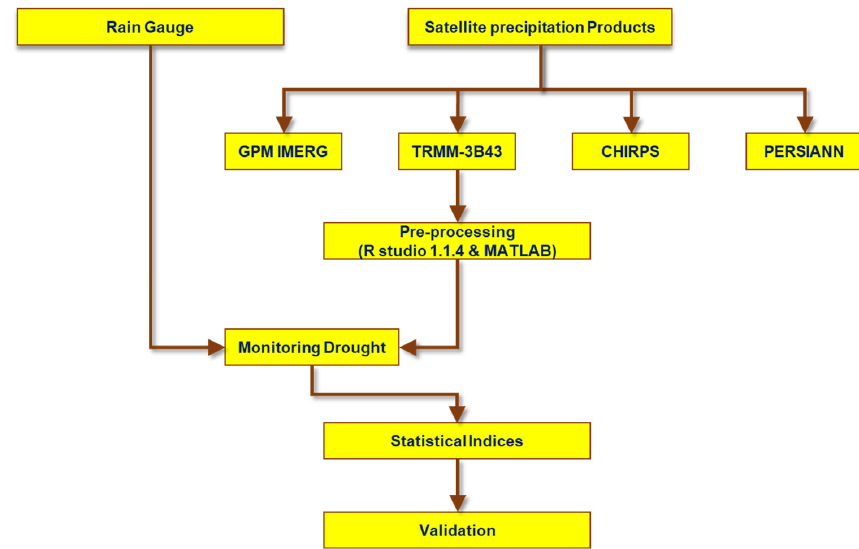
Figure 3. Methodology for validation of satellite precipitation products.